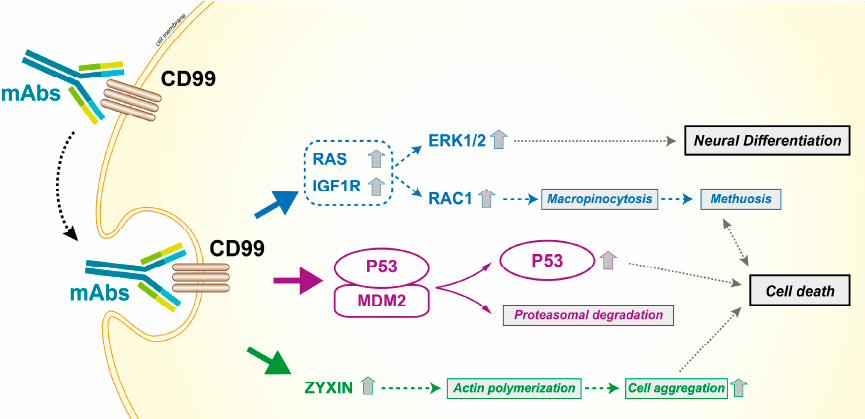
Figure 6. Effects of CD99 triggering by antibodies in Ewing sarcoma cells. CD99 engagement reduces the malignancy of tumor cells and induces caspase-independent cell death. The antibody-mediated engagement of CD99 induces a rapid caveolin-1-dependent endocytosis and promotes the upregulation of IGF1R and RAS signaling. The activation of the two downstream effectors Rac1 and ERK1/2 leads to macropinocytosis and death by methuosis or neural differentiation, respectively [59,96]. The effects are more dramatic in malignant cells that express high levels of CD99 and are facilitated by the reactivation of P53, resulting from the CD99-induced degradation of MDM2 [51–53,92]. Moreover, CD99 ligation upregulates zyxin that is associated with actin filaments and cell aggregation, a process also required for cell death [52].